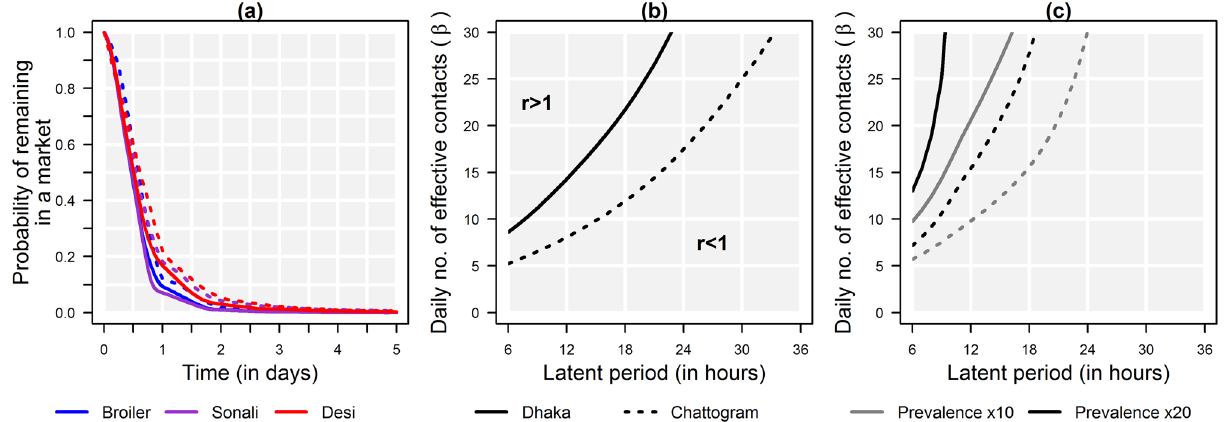
Figure 3. Chicken and AIV dynamics in a market. ( a ) Probability of a chicken remaining in a market as a function of time, for broilers (blue), sonalis (purple), deshis (red), in Dhaka (solid) and Chattogram (dotted); ( b ) Values of β required for r = 1 as a function of the latent period; β refers here to the average daily number of effective contacts (i.e. resulting in infection if involving a susceptible and an infected bird), in a closed population, accounting for both direct and environmentally-mediated transmission; values of β result in r > 1 above the solid line for Dhaka markets and dotted line for Chattogram markets, and in r < 1 below these; ( c ) Values of β required for a 10- and 20-fold increase in the prevalence of infection as a function of the latent period; grey: tenfold, back: